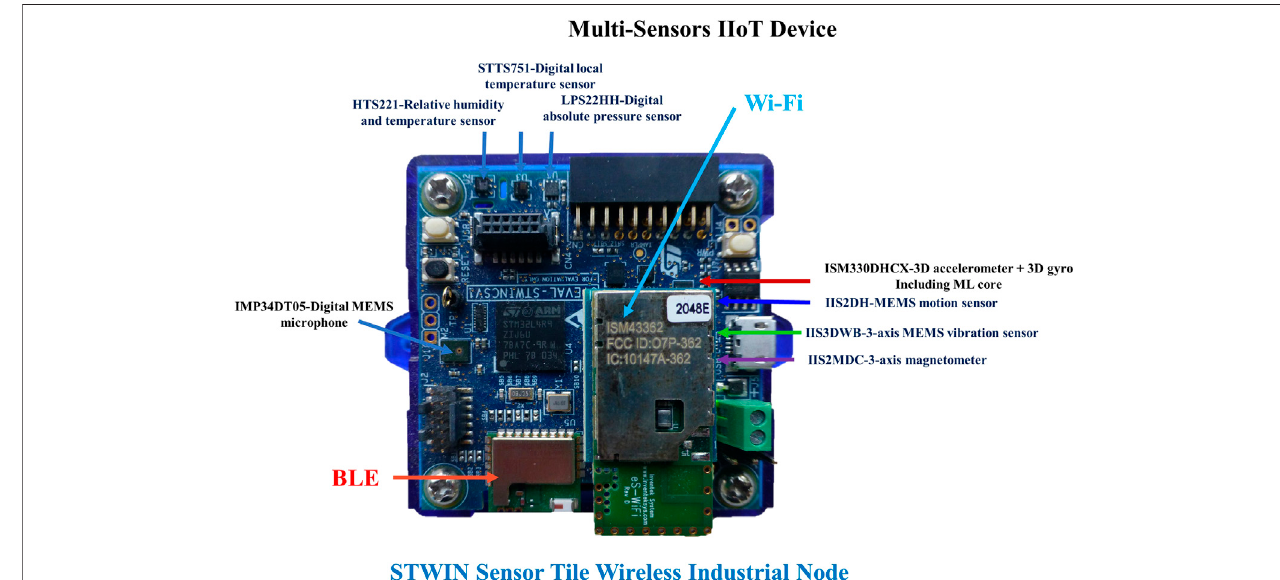
FIGURE 6 | STWIN sensor tile wireless industrial